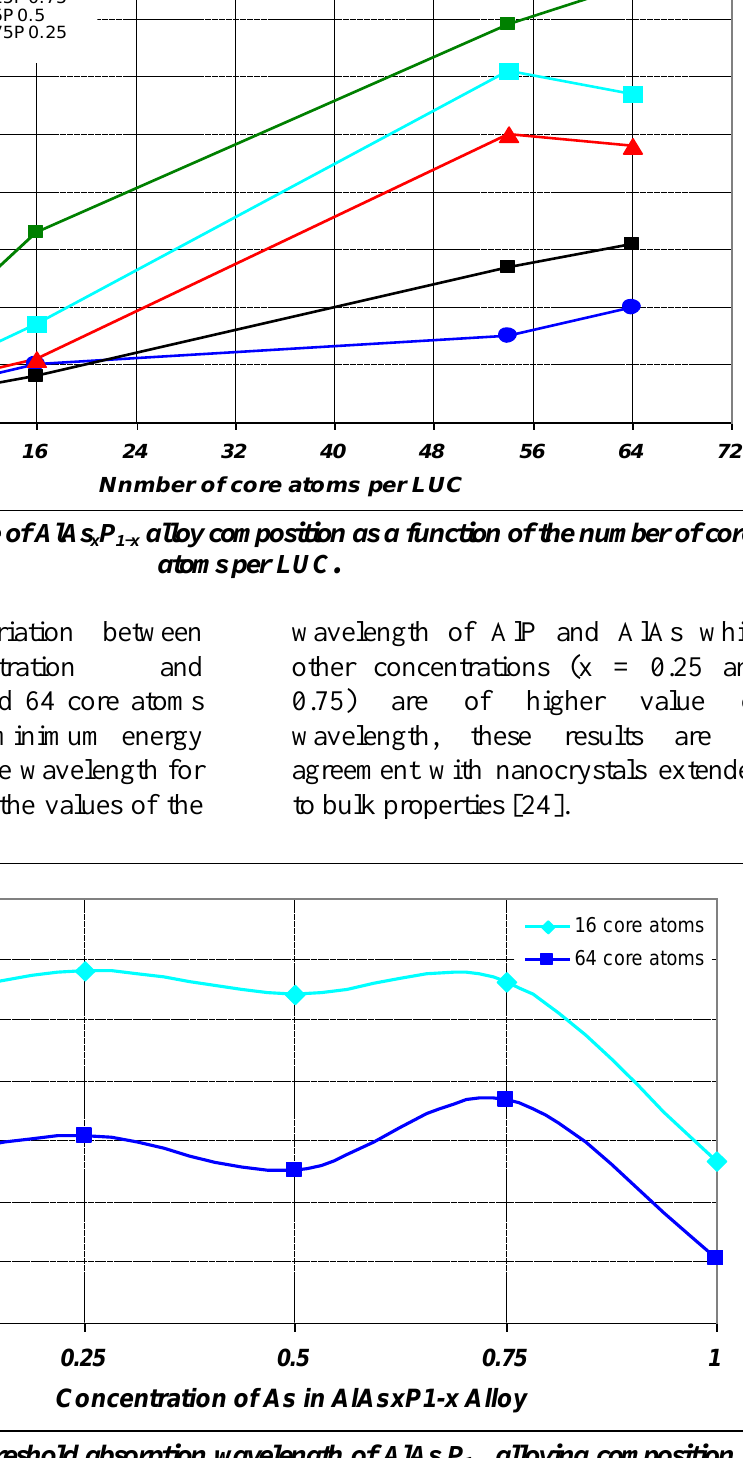
P alloying composition as x 1-x